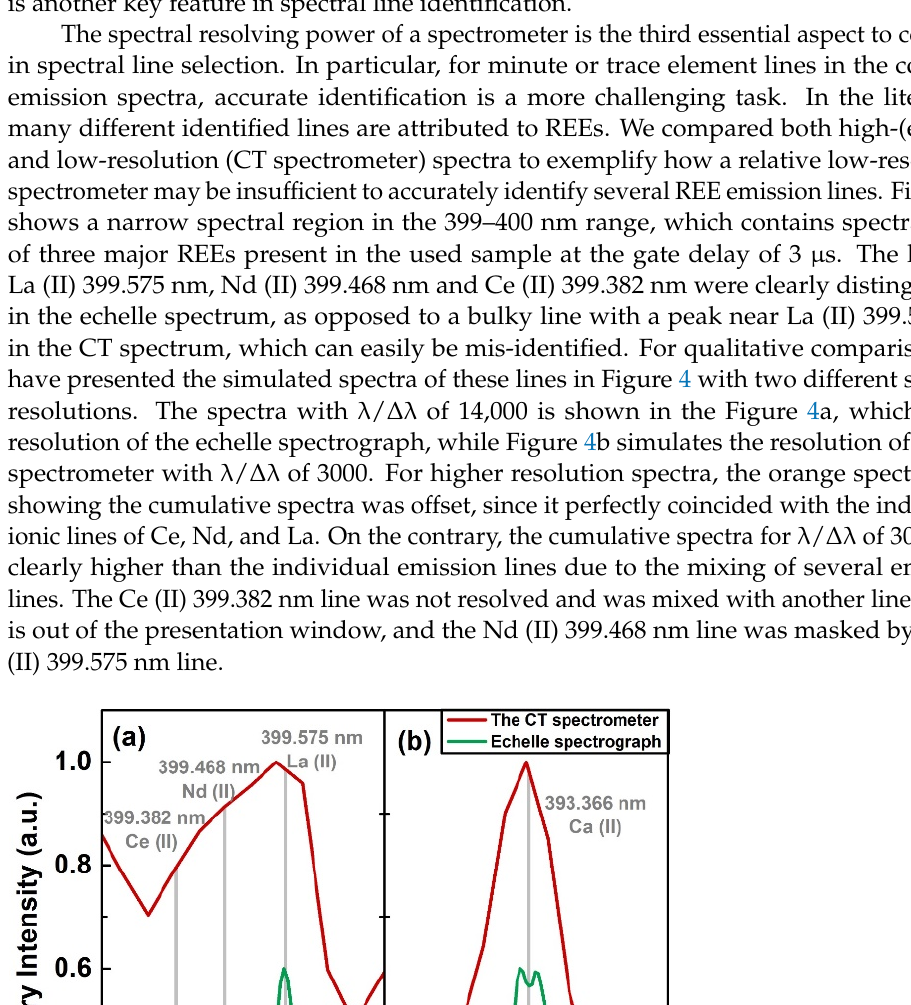
Figure 4. The simulated spectra of Ce (II), Nd (II) and La (II) in our sample with two different spec- tral resolutions in the spectral range of 399–400 nm. For echelle spectrograph in ( a ) and for the CT spectrometer in ( b ). The spectral parameters were: T = 5500 K and n e = 1 × 10 17 cm − 3 . Likewise, a very strong and distinct Ca (II) 393.366 nm line is shown in Figure 3b. A clear self-reversal was overlooked by the CT spectrometer, and the use of this spectrum for parametric analysis such as electron number density can make the analysis signifi- cantly erroneous. It is important to emphasize that both spectra were taken from the same plasma region by careful adjustment of the spectral collection setup. This comparison elu- cidated that a relative low-resolution spectrometer may not be appropriate for the identi- fication of relatively weaker emission lines. In addition, the long-term spectrometer drift should be carefully taken into account using standard light sources or obvious emission lines; overlooking spectral drift is another source of mis-classification of the emission lines in a complex spectrum.